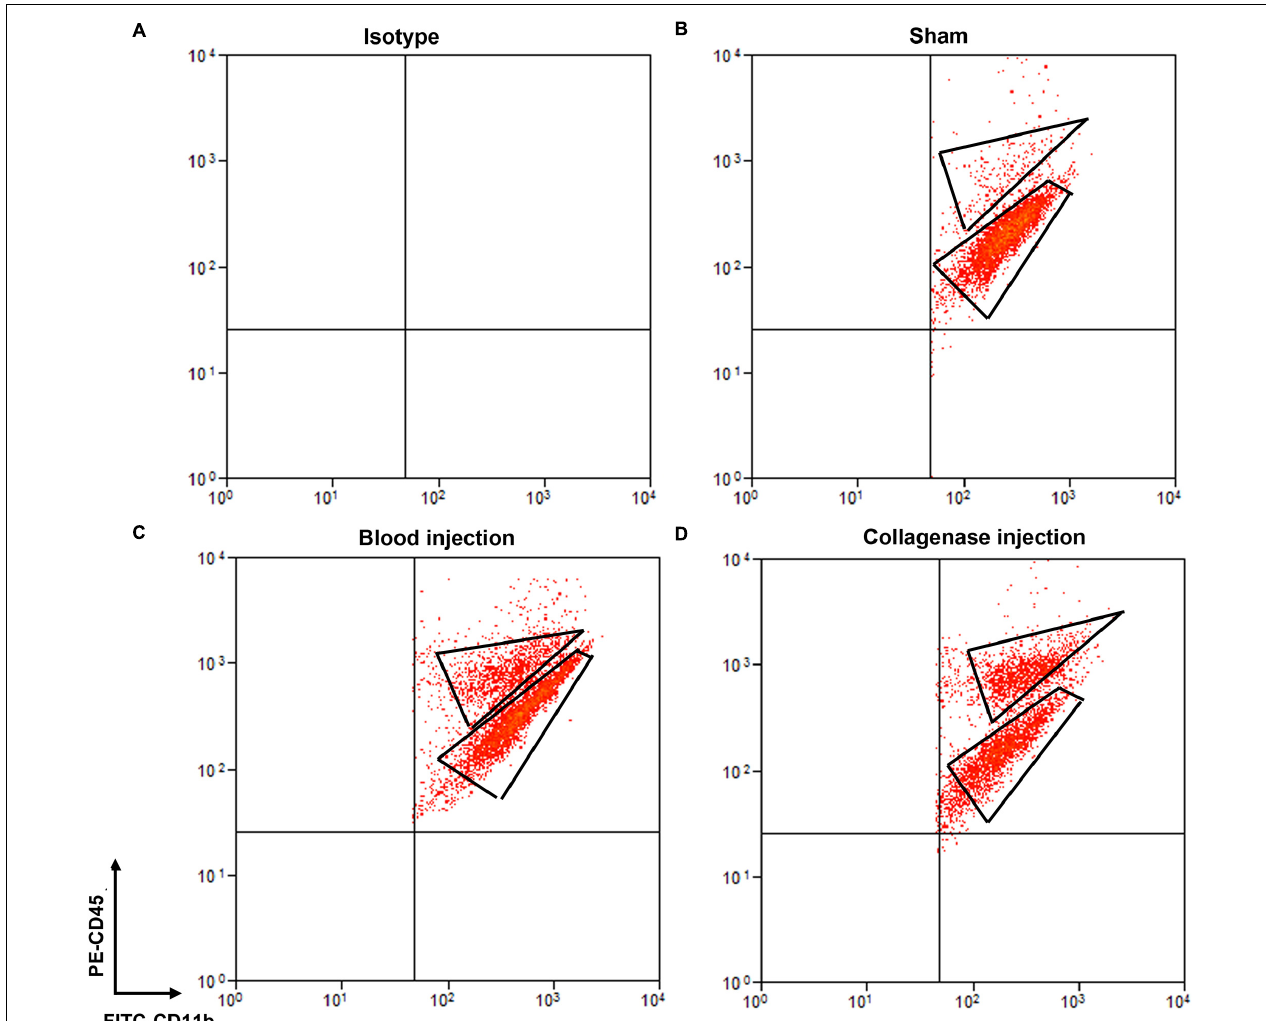
FIGURE 4 | Separation of microglia and monocytes/macrophages by flow cytometry on day 1 after blood-induced or collagenase-induced ICH. Eight- to ten-week-old male C57BL/6 mice underwent collagenase injection, blood injection, or sham procedure. Mice were sacrificed at day 1 post-ICH. Mouse brain was perfused with phosphate-buffered saline and dissociated into single cells. Cells were stained with propidium iodide (PI) and isotype (A) or APC-Ly6g, FITC-CD11b, and PE-CD45 (B–D) for flow cytometry. Representative images show cell populations in each group, and gates show cells sorted into Ly6g − CD11b + CD45 high PI − and Ly6g − CD11b + CD45 Int PI −